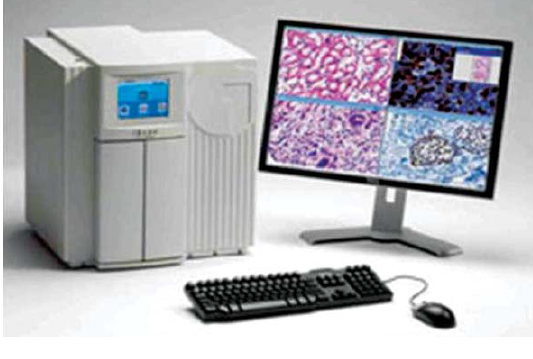
Fig. 3. WSI unit, Cairo